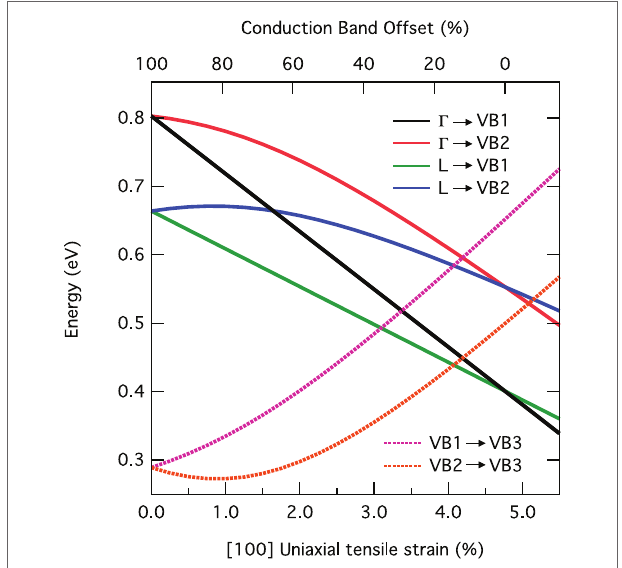
FiGURe 3 | Transition energies between the direct and indirect conduction band valleys and the two top valence bands and within the valence band of uniaxially, tensilely stressed Ge . For a strain of ~4.7%, the conduction band minimum at the Γ -point reaches a lower energy than the indirect L-valleys. The upper x -axis denotes the offset between the Γ - and L-band edges in relative units.